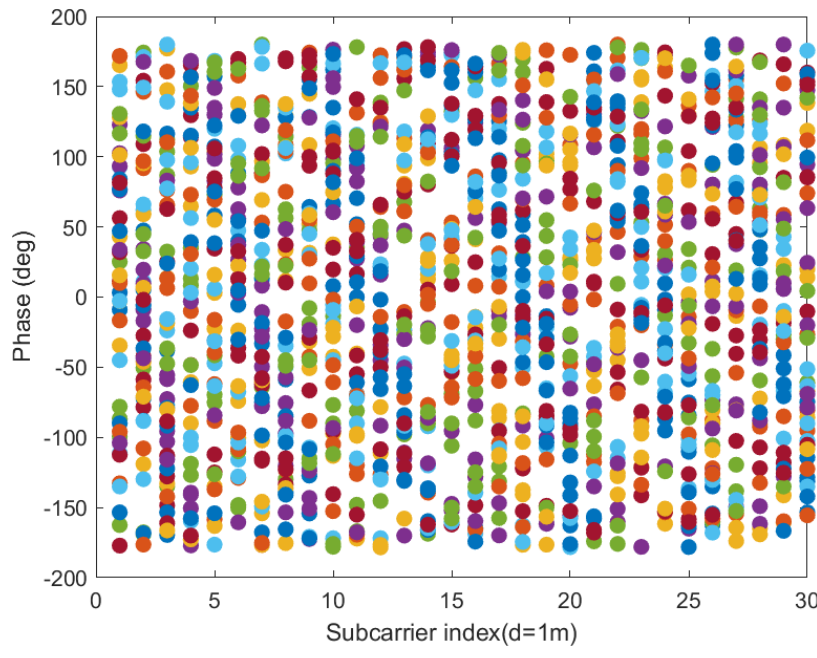
Figure 4. The phase frequency response of CFR under three receiving